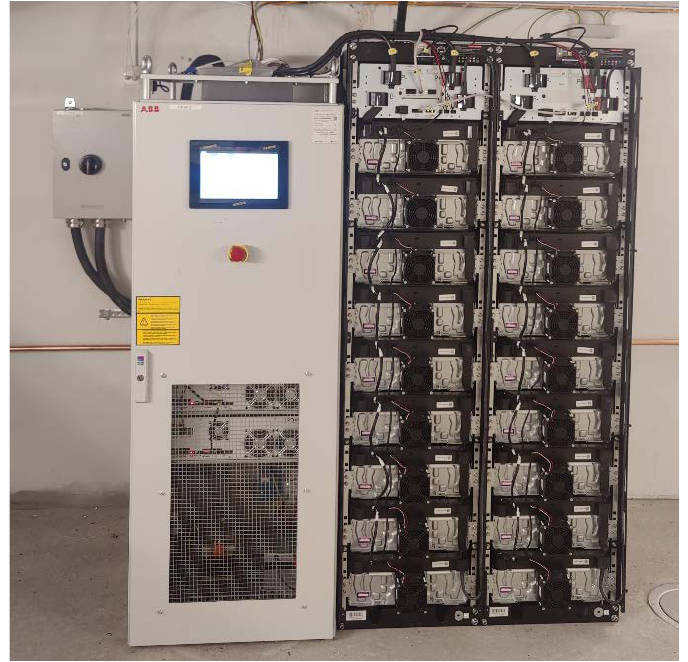
Figure 2. Battery ES system at